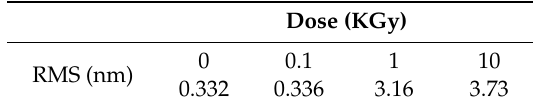
Table 1. The root means square (RMS) roughness of Si-doped GaAs under 0, 0.1, 1 and 10 KGy γ -radiation.